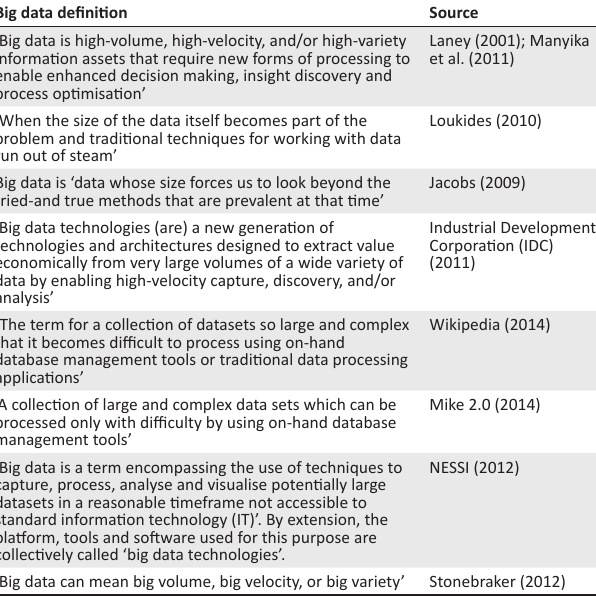
TABLE 1: Definitions of big